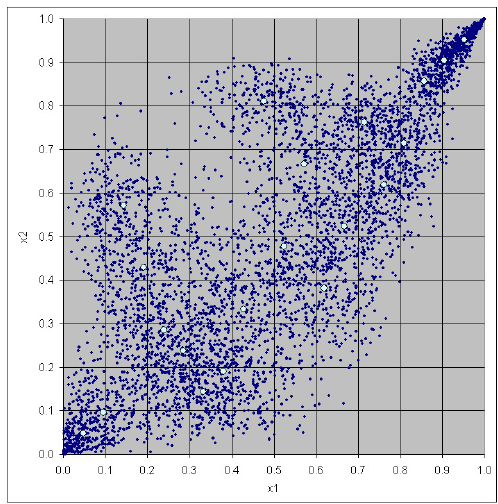
Figure 20. Gamma UF copula, a =